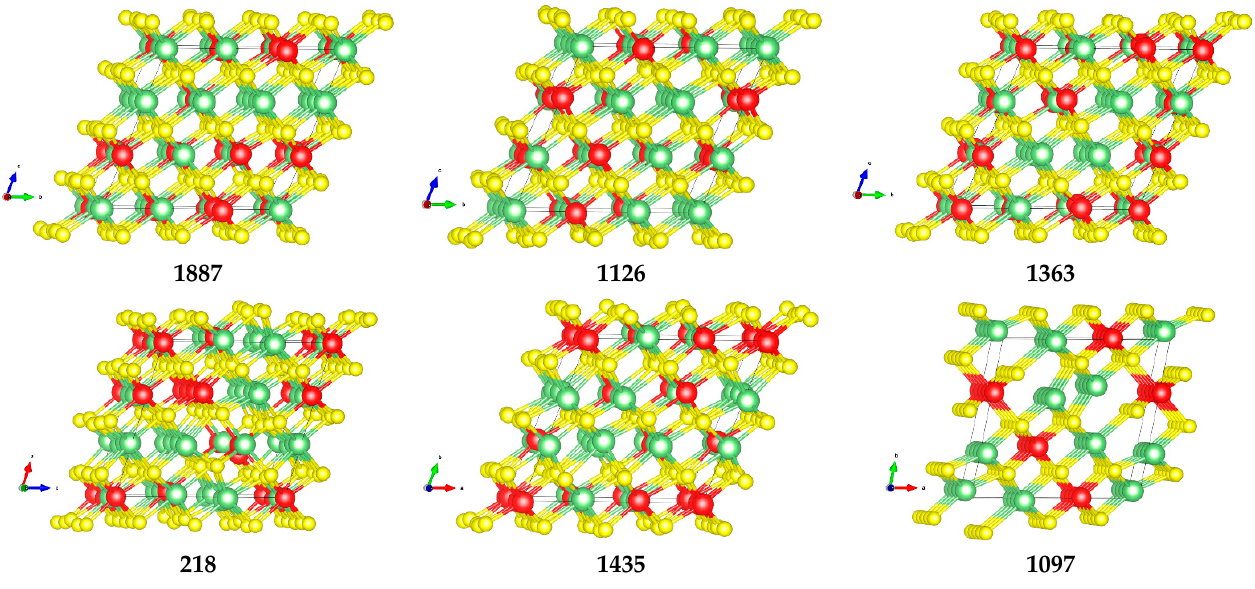
Figure 4. Examples of dispersed and ordered structures: 1887 , 1126 , 1363 , 218 , 1435, and 1097 . Ti (red), Li (green), S (yellow). The structures are represented in their primitive crystal lattice and in different orientations in order to highlight rows/planes when present. The structures were visualized and the figures were produced with the help of VESTA software [41]. Table 4. Energetic, electronic, and structural data for six selected structures. Δ E is the relative stability (in eV/FU) of the pseudocubic structures with respect to the monoclinic one; V1 is the volume of the primitive cell; q is the gross Mulliken charge in |e|. See also Figure 4.